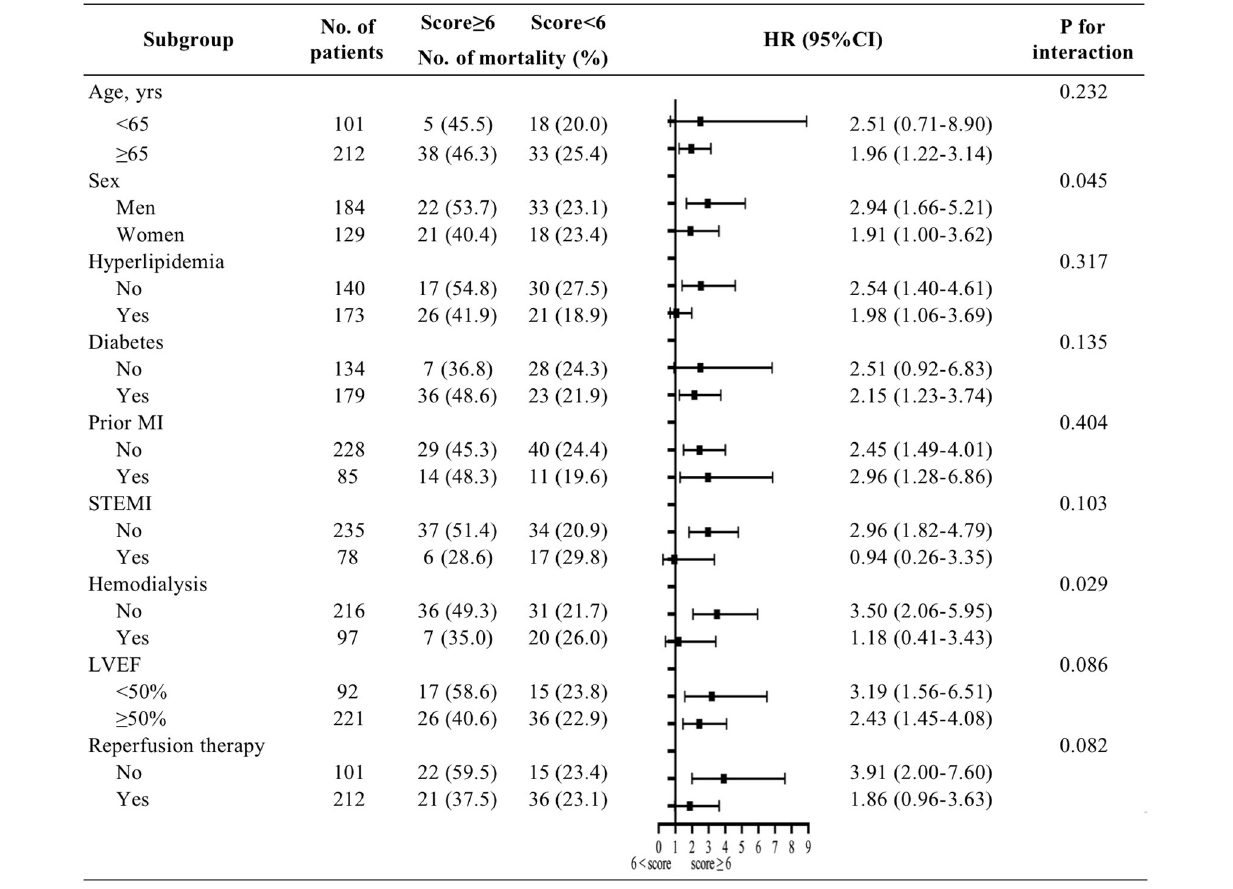
FIGURE 2 | Predictive value of CHA 2 DS 2 -VASC score for all-cause mortality in different